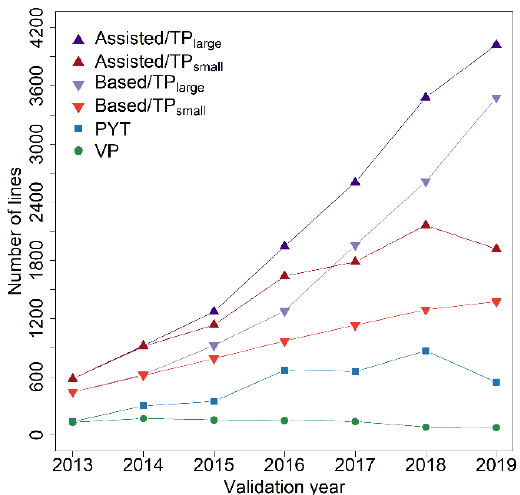
12 of 20 phenotypic selection based on preliminary yield trials (green horizontal line). The employed training populations included all available lines tested in multi-environment trials preceding a specific validation year, whereas both scenarios without (TP small ) or with augmenting the training population with lines tested in all preliminary yield trials preceding a validation year (TP large ) were considered. All prediction models were fitted either without including preexisting information of a specific validation population from the preliminary yield trial preceding the validation year (“Based”- predictions) or with including this source of phenotypic information into the training population (“Assisted”-predictions). Combining data from all previous multi-environment and preliminary yield trials for prediction model training was used to test the merit of vastly increasing the size of the training population for the mentioned models, especially for the more recent years (Figure 6). This augmentation of the